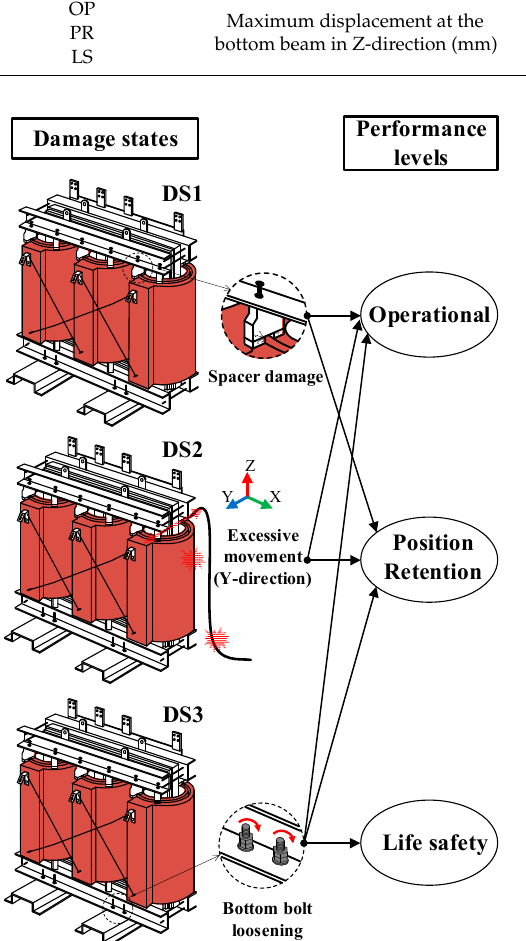
Figure 16. Correlation between damage states and performance levels of the mold transformer.